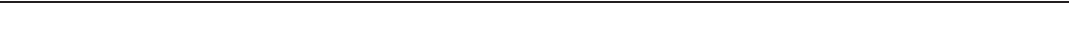
Fig. 19. Fruits of Icacinaceae Miers. 1 – 8 . Miquelia caudata King ( Mohd, Shah & Sidek 1168 ). 1 . Dried fruit with acuminate apex and an elongate gynophore (here broken), lateral view. 2 – 6 . Endocarp. 2 . Lateral view showing ridges and pits. 3 . Dorsal view showing a keel surrounding the endocarp. 4 . Opposite lateral view. 5 . Apical view. 6 . Basal view. 7 . SEM image of the bullate tubercle in the locule. 8 . SEM image of the papillae on the tubercle surface. – 9 – 17 . Miquelia celebica Blume ( J.S.A. Kruiff 23 ). 9 . Dried fruit with an elongate gynophore, lateral view. 10 – 14 . Endocarp. 10 . Lateral view showing ridges and pits. 11 . Dorsal view showing a keel surrounding the endocarp. 12 . Opposite lateral view. 13 . Apical view. 14 . Basal view. 15 . SEM image of the pericarp in transverse section showing a ridge. 16 . SEM image of the pericarp in transverse section showing the bullate tubercle. 17 . SEM image of the inner part of the endocarp in transverse section showing papillae. – 18 – 26 . Natsiatum herpeticum Buch.- Ham. ex Arn. ( H.B. Cale s.n. ). 18 . Broken dried fruit, lateral view. 19 – 23 . Broken endocarp. 19 . Lateral view showing the ridges. 20 . Dorsal view showing a keel surrounding the endocarp. 21 . Opposite lateral view. 22 . Apical view. 23 . Basal view. 24 . SEM image of the pericarp in transverse section showing the channel with the vascular bundle (arrow). 25 . SEM image of the pericarp in transverse section showing the ridge. 26 . Detail showing cells of the endocarp. Images taken from Del Rio (2018). Scale bars: 1–6, 9–14, 18–23 = 10 mm; 15, 24 = 1 mm; 7, 16, 25 = 500 μm; 26 = 200 μm; 8, 17 = 50